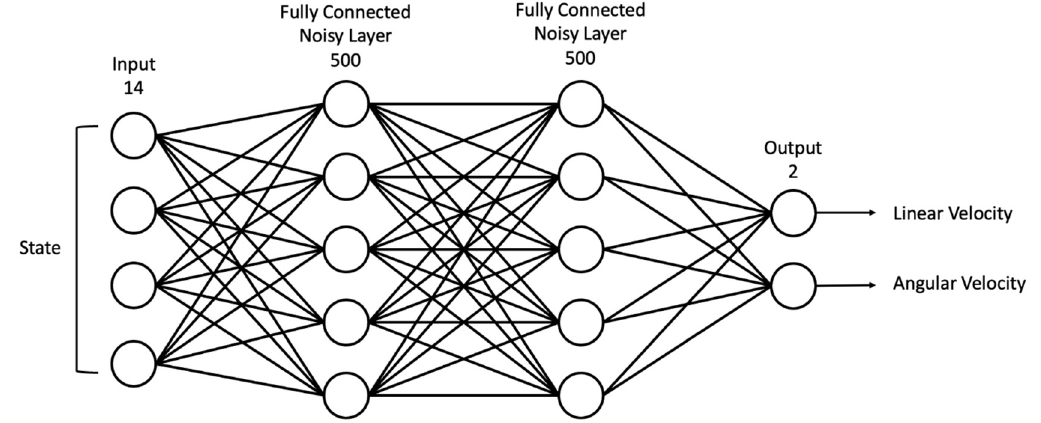
Figure 3. Actor network structure consisting of fully connected layers with noise.